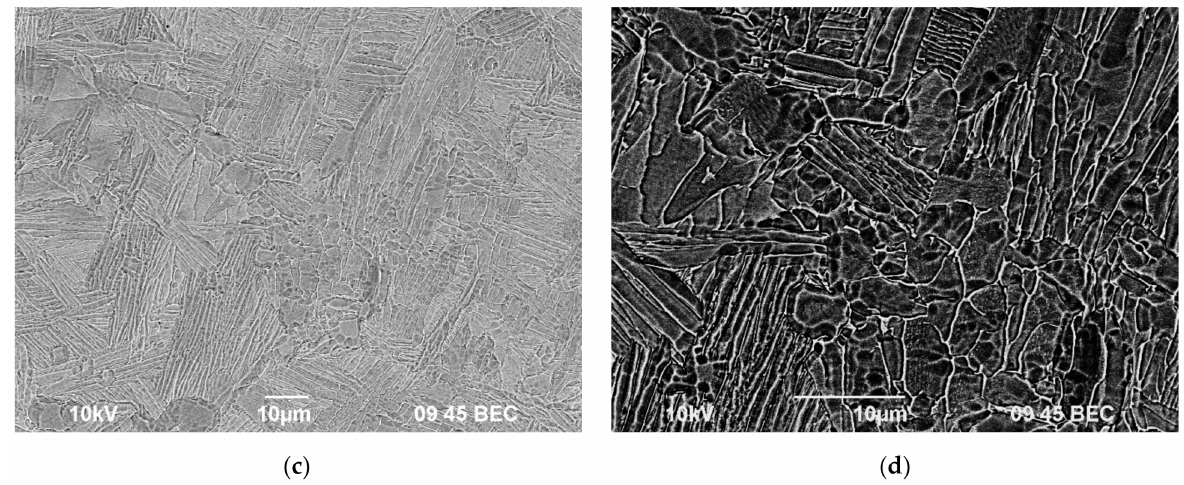
Figure 2. Microstructure of the Ti ( a ), Ti5Al2V ( b ), and Ti6Al4V ( c , d ) alloys. SEM (BEC mode).